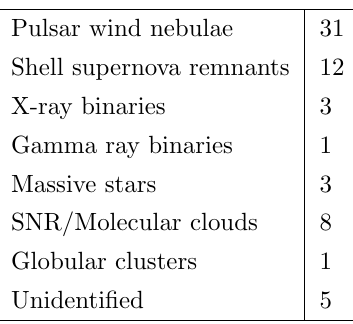
Table 1: Galactic TeV gamma ray sources